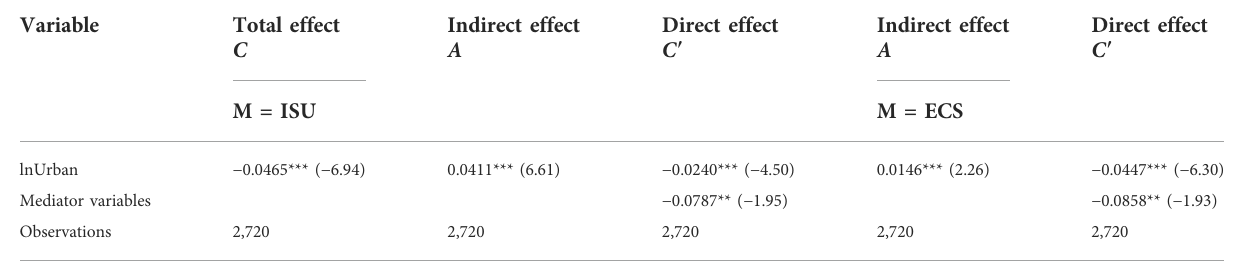
TABLE 7 Analysis of the mediating effect.